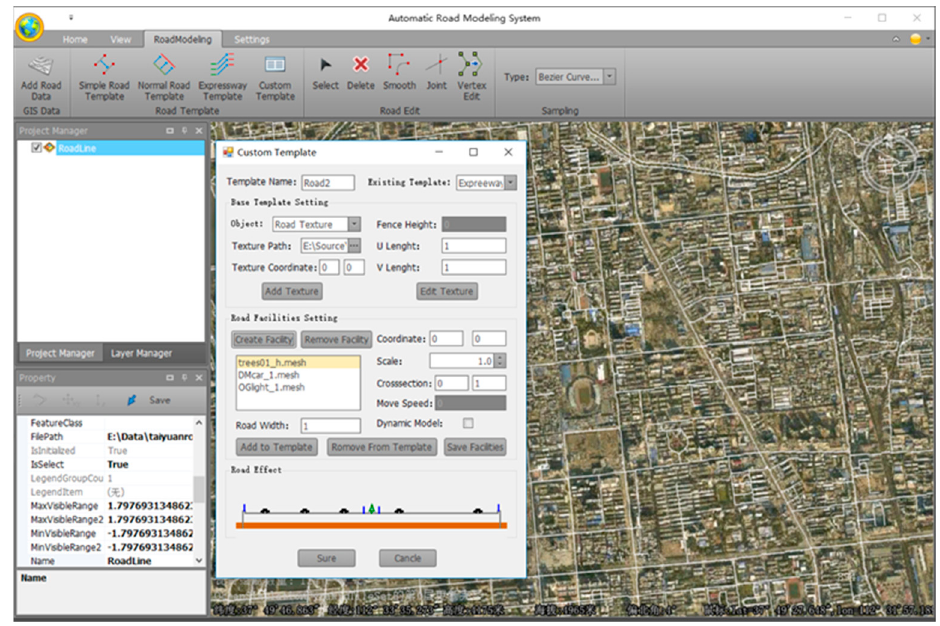
Figure 12. Road network modeling system.